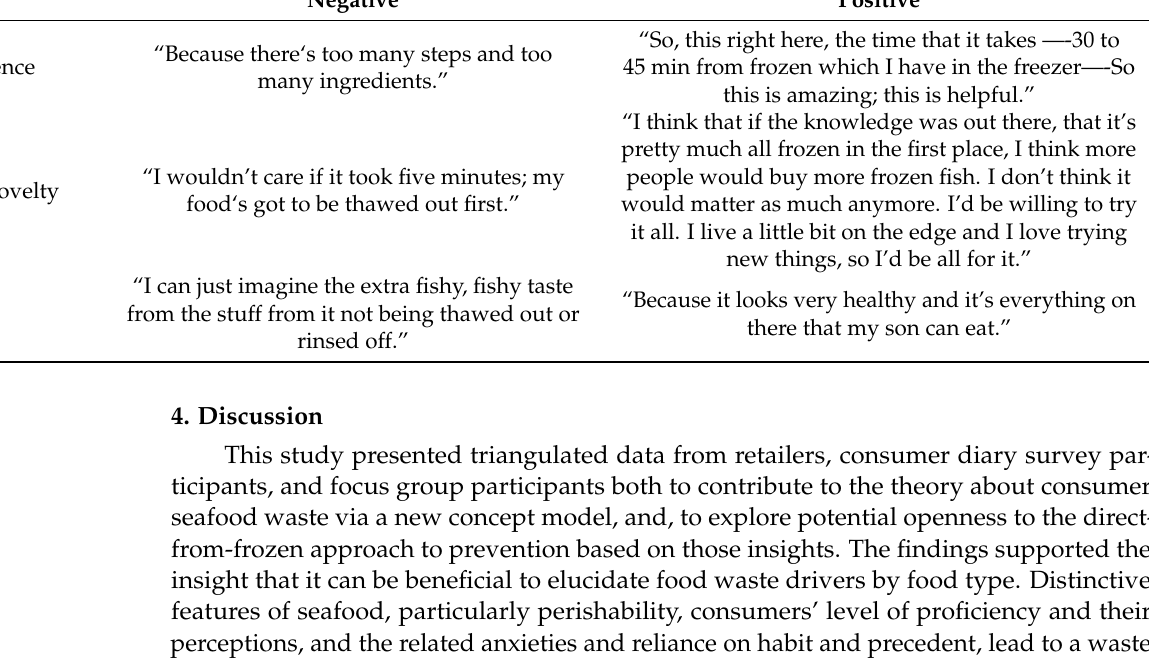
Table 6. Attitudes toward cooking direct-from-frozen seafood after the introduction of recipes. Focus group, illustrative quotes. Negative